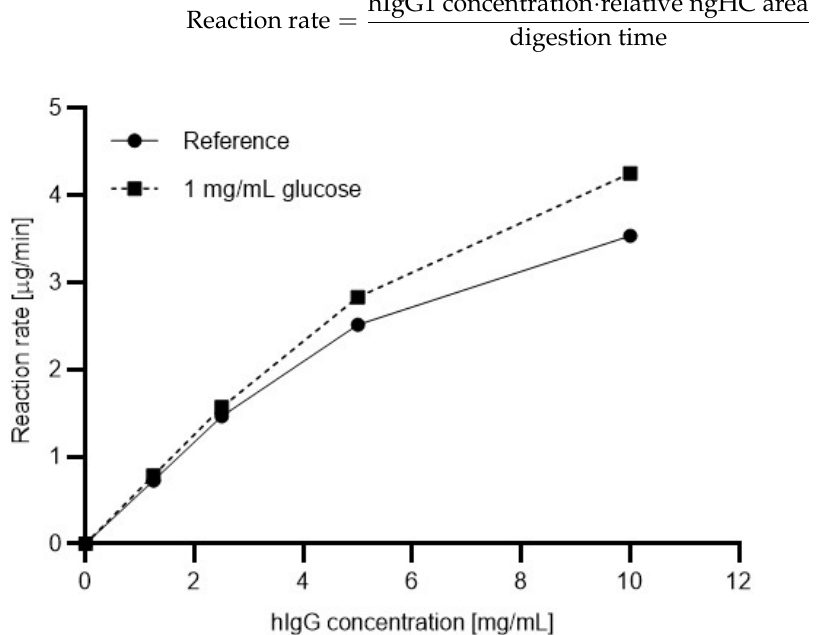
Figure 3. Michaelis-Menten deglycosylation plots using the in-house produced 6His-PNGase F enzyme with (dashed line) and without (solid line, reference) the presence of glucose (1 mg/mL) in the reaction mixture.